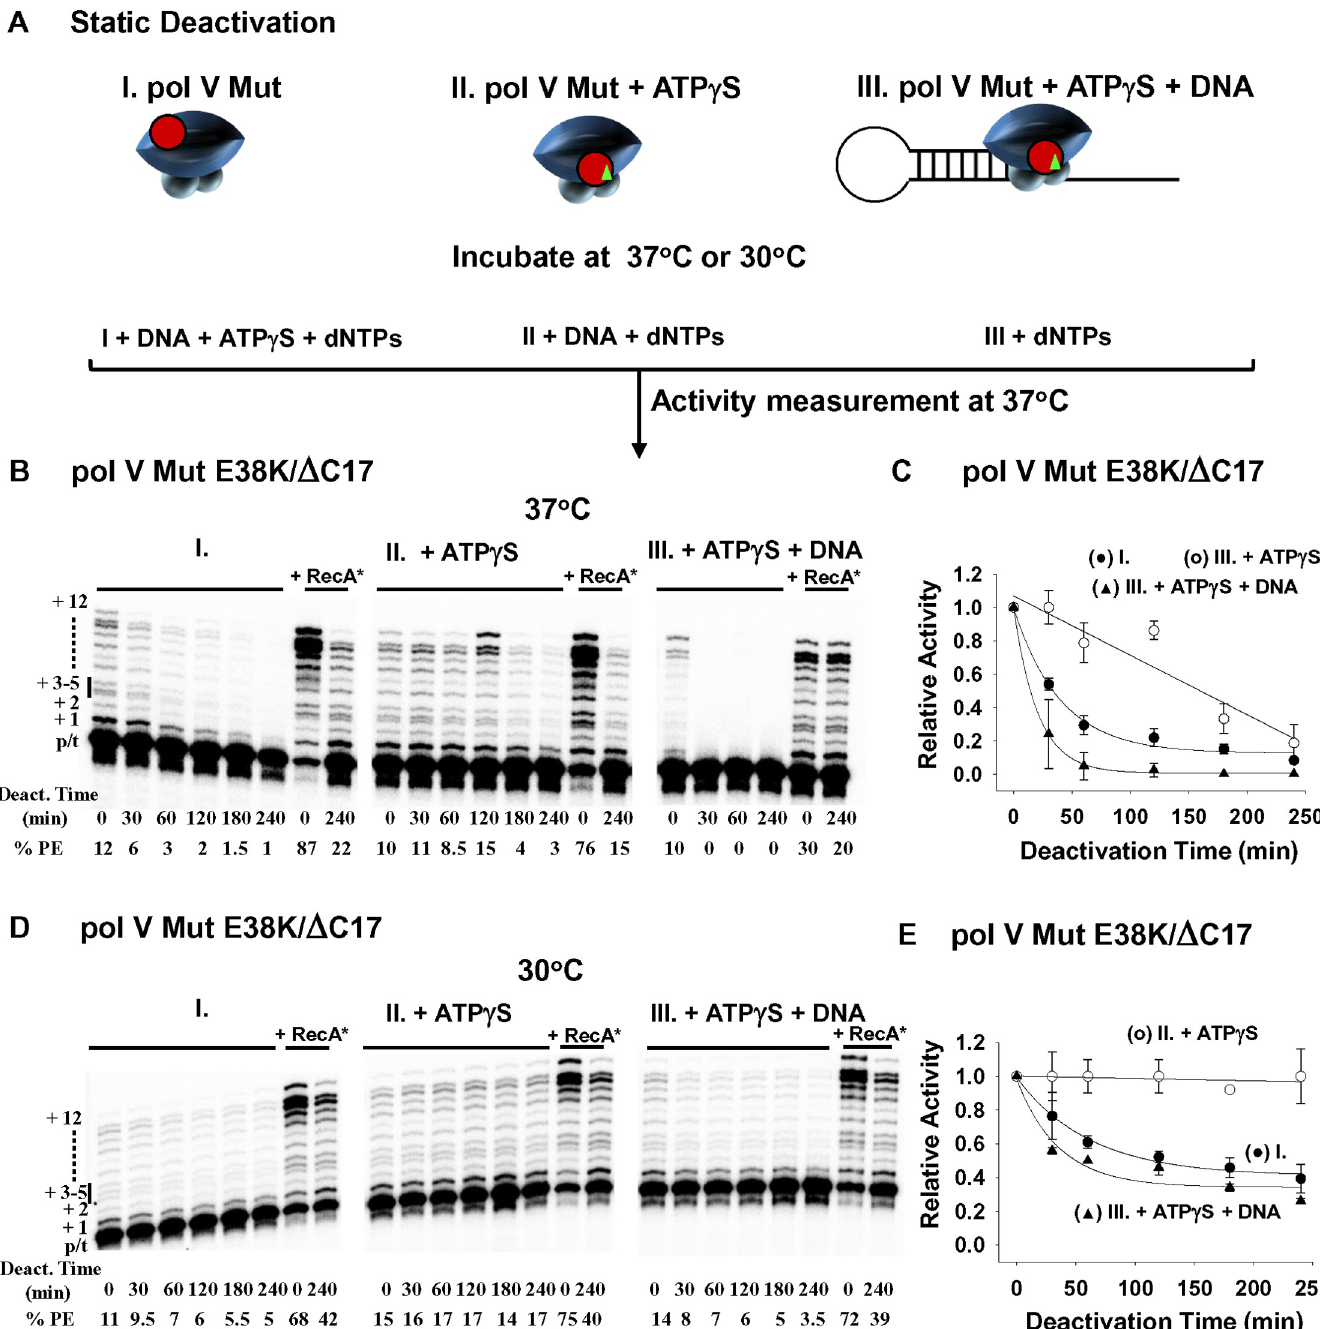
Fig 4. Static Deactivation of pol V Mut E38K/ Δ C17 at 37˚C and 30˚C. (A) Sketch showing static deactivation of pol V Mut E38K/ Δ C17 (200 nM) in the absence of DNA synthesis at 37˚C and 30˚C. Static deactivation was determined by measuring the extent of DNA synthesis as a function of incubation time on 12 nt oh HP p/t DNA at 37˚C in the presence of ATP γ S and dNTP’s (dTTP, dCTP, dGTP 500 μ M each). Pol V Mut E38K/ Δ C17 was incubated either alone (I.) or with ATP γ S (II.), or with ATP γ S and 12nt oh HP DNA (III.). (B) and (D) show representative gels for each deactivation condition. Pol V Mut E38K/ Δ C17 deactivates more slowly at 30˚C (D-E) compared to 37˚C (B-C). At each temperature, pol V Mut is stabilized when incubated in the presence of ATP γ S. Deactivated pol V Mut E38K/ Δ C17 is not dead since it can be reactivated by incubation with RecA � (+RecA � ). Static deactivation is expressed as the relative polymerase activity measured at each incubation time point divided by the polymerase activity measured at t = 0. Each experiment was repeated 2–3 times and average relative activity along with SD for each deactivation time point are presented in (C) and (D). (I. and black circles in the graphs) represent static deactivation of pol V Mut alone, (II. and white circles in the graphs) represent deactivation of pol V Mut +ATP γ S and (III. and black triangles in the graphs) represent deactivation of pol V Mut + ATP γ S + 12 nt oh HP.